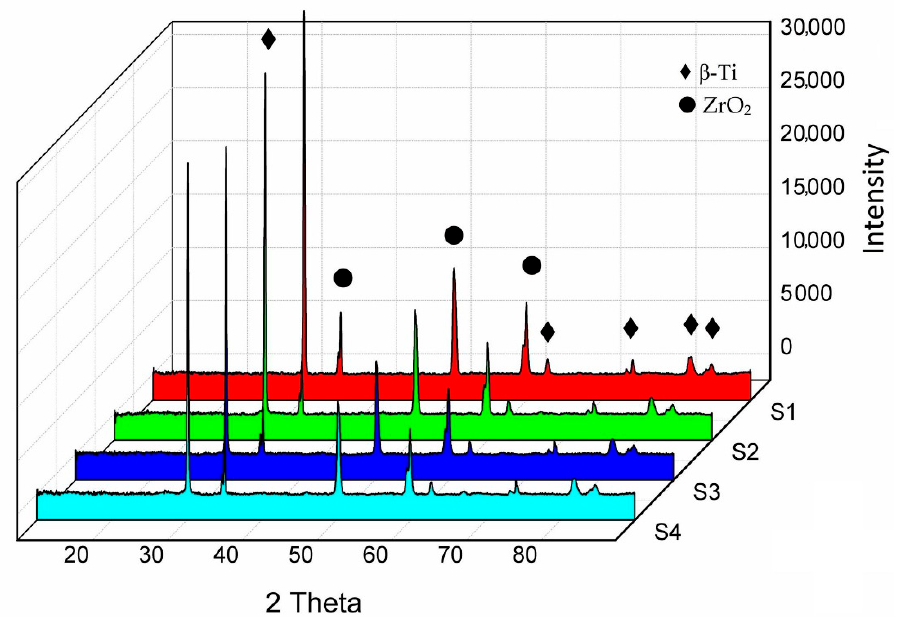
Figure 5. XRD patterns for coated samples: S1-ZrO 2 , S2-ZrO 2 , S3-ZrO 2 , S4-ZrO 2 .